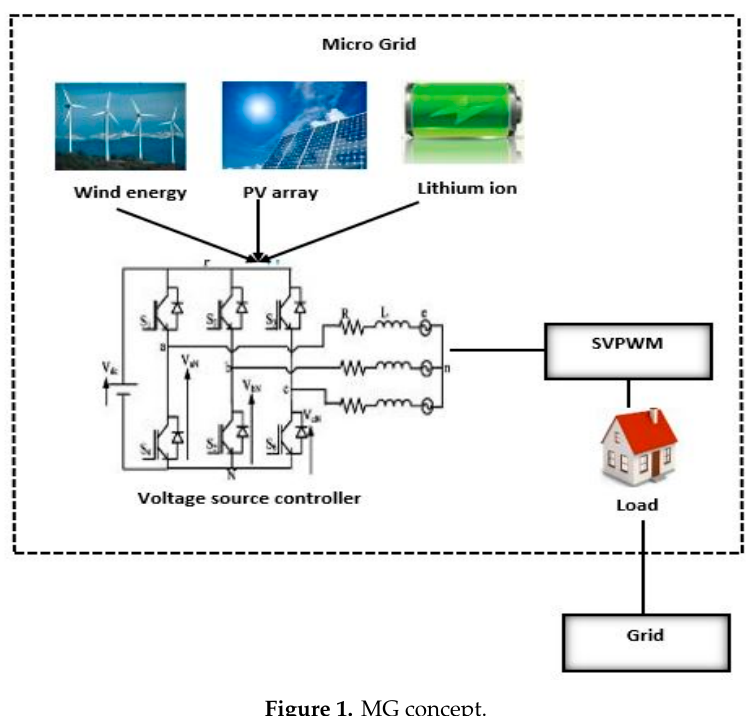
Figure 1. MG Figure 1. MG concept.